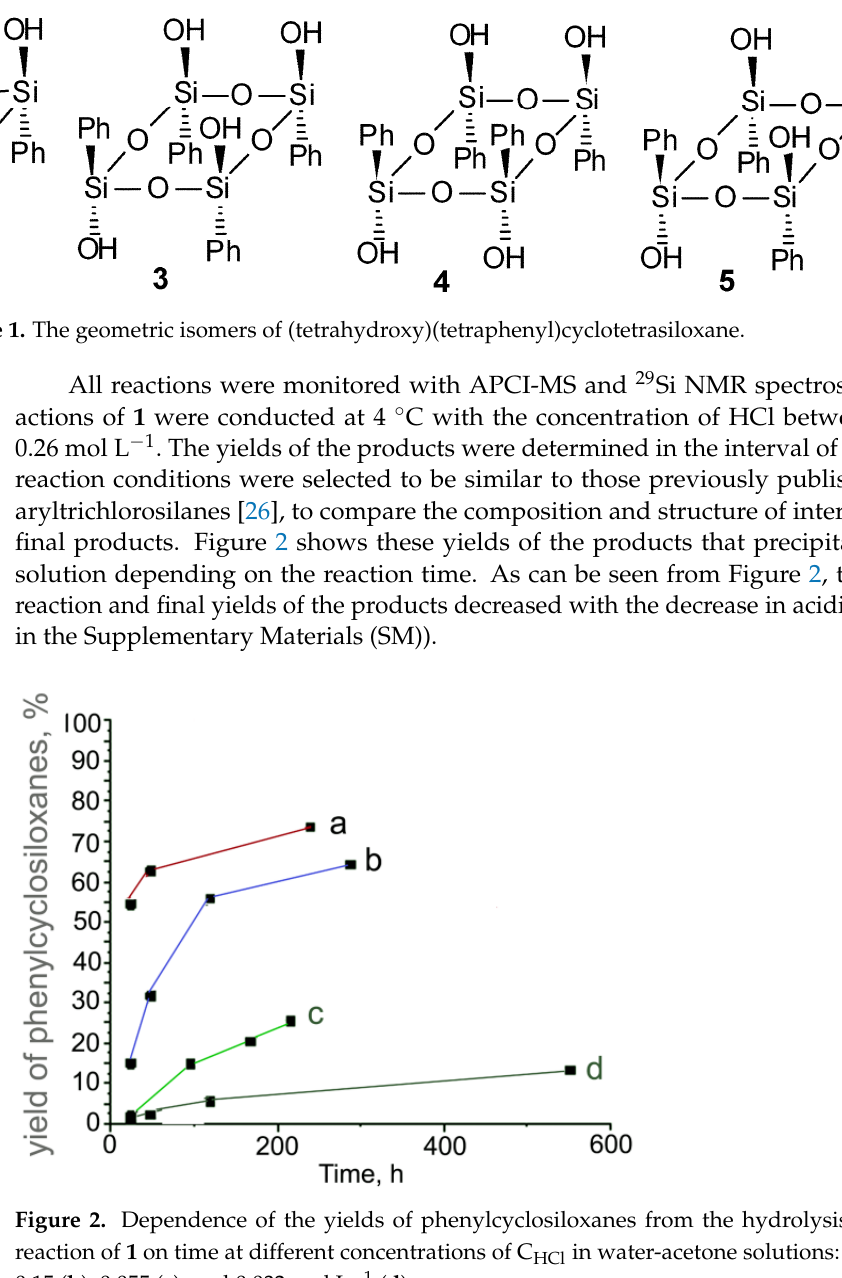
Figure 1. The geometric isomers of (tetrahydroxy)(tetraphenyl)cyclotetrasiloxane.